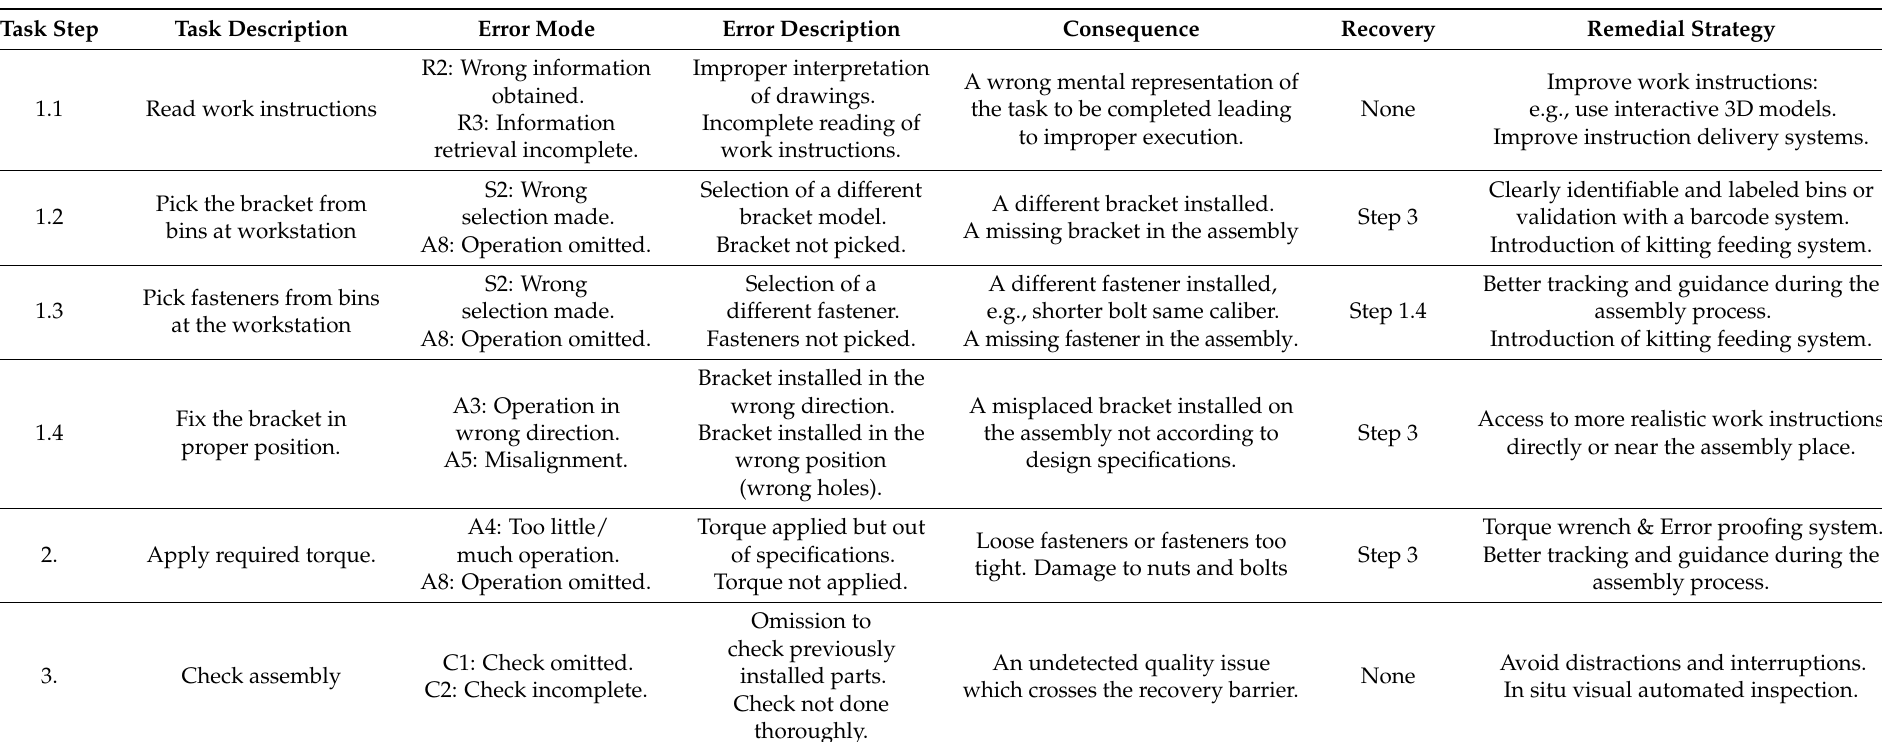
Table 2. SHERPA output-human error analysis table for critical task No.1 (install brackets) 1